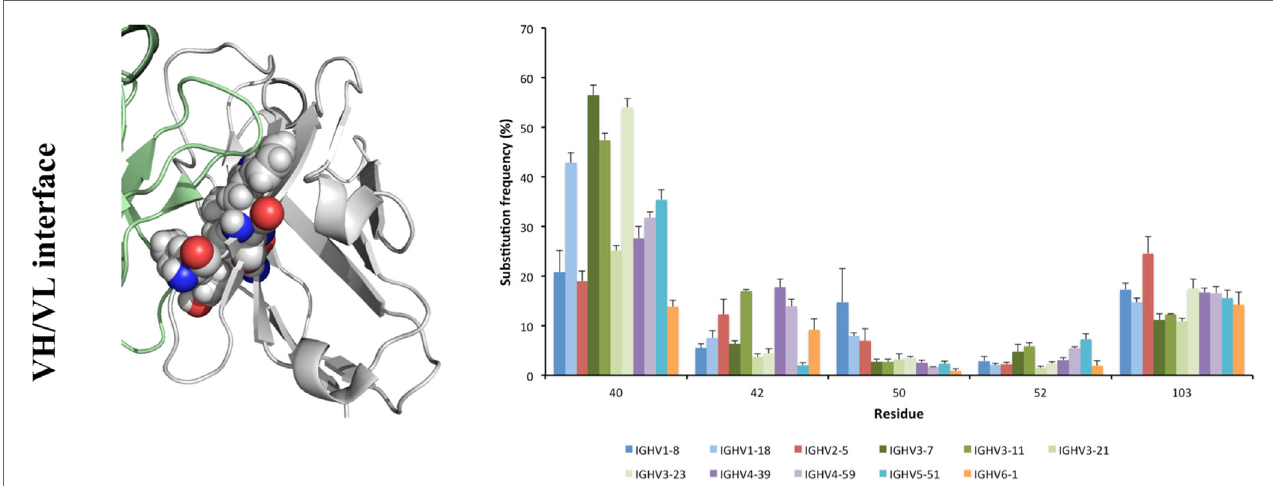
FigUre 6 | Substitution frequency of the charge cluster, lower and upper cores, and major residues that participate in VH/VL interface of the antibody H chain. Error bars indicate SEM between repertoires of different donors. Residues belonging to these structures include those exemplified in the structure of the VH of a human antibody fragment with an origin in germline gene IGHV1-18 (PDB: 3SDY). The VH domain is shown with a gray backbone. Part of the VL domain in the illustration of the domain interface is shown in green. Achieved diversity of individual residues in the sequence populations are outlined in Figures 7 – 9 , and Figure S4 in Supplementary Material.